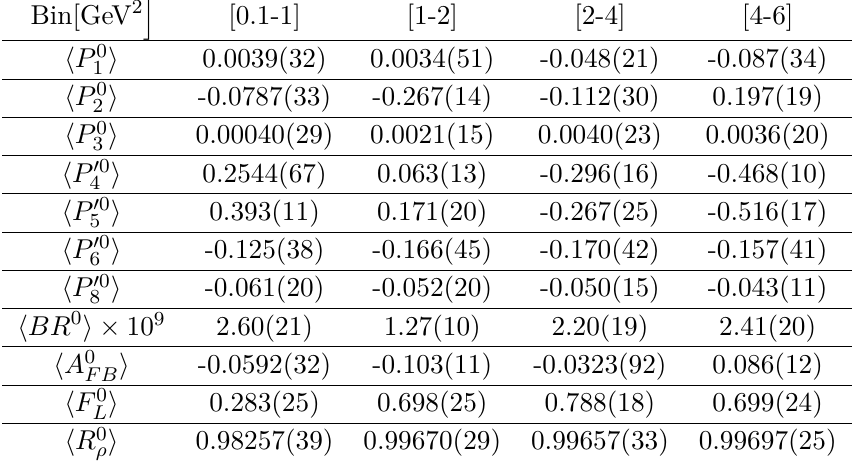
Table 14 . Predictions of observables, in the SM, for B 0 → ρ 0 ‘‘ decays, which are measurable at Belle.